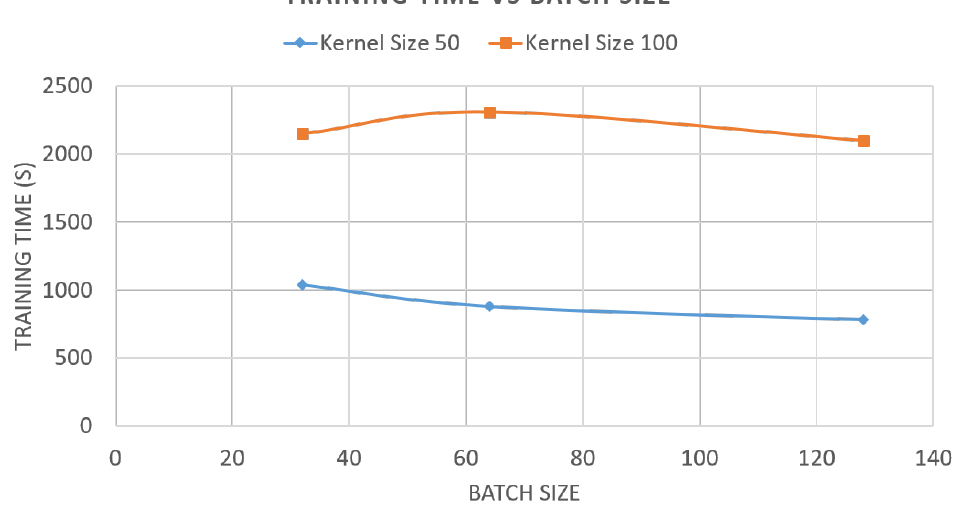
Figure 8. Comparison between the total training time and batch size for the FNN when fixing the kernel size to 50 (blue) and 100 (orange).